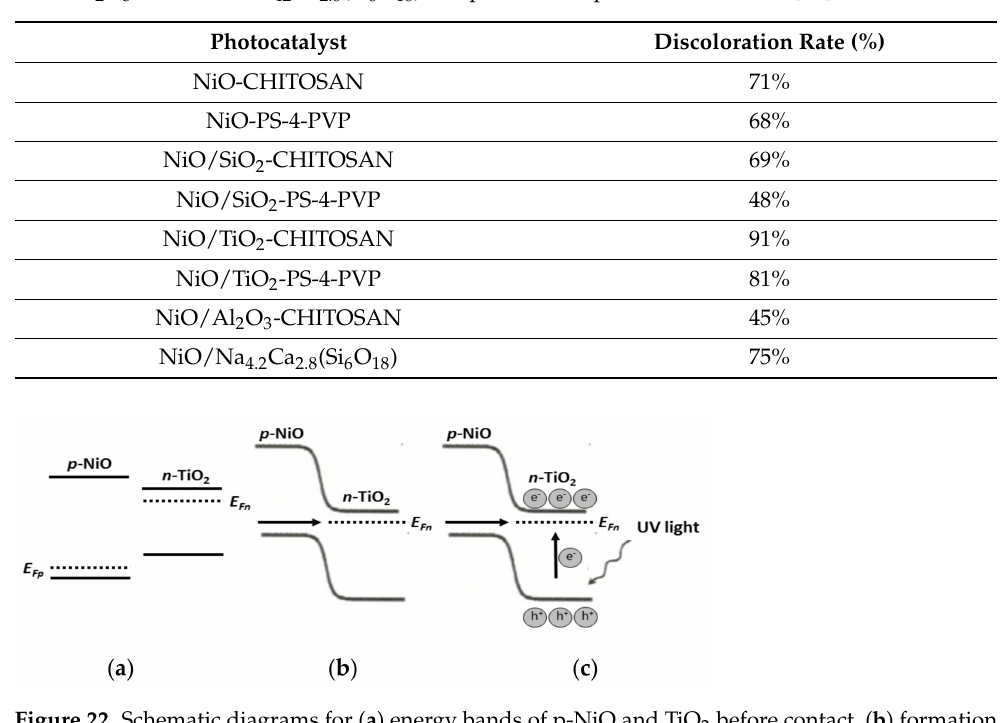
Figure 22. Schematic diagrams for ( a ) energy bands of p-NiO and TiO 2 before contact, ( b ) formation of the p-n junction and its energy diagram at equilibrium, and ( c ) transfer of holes from n-TiO 2 to p-NiO under UV